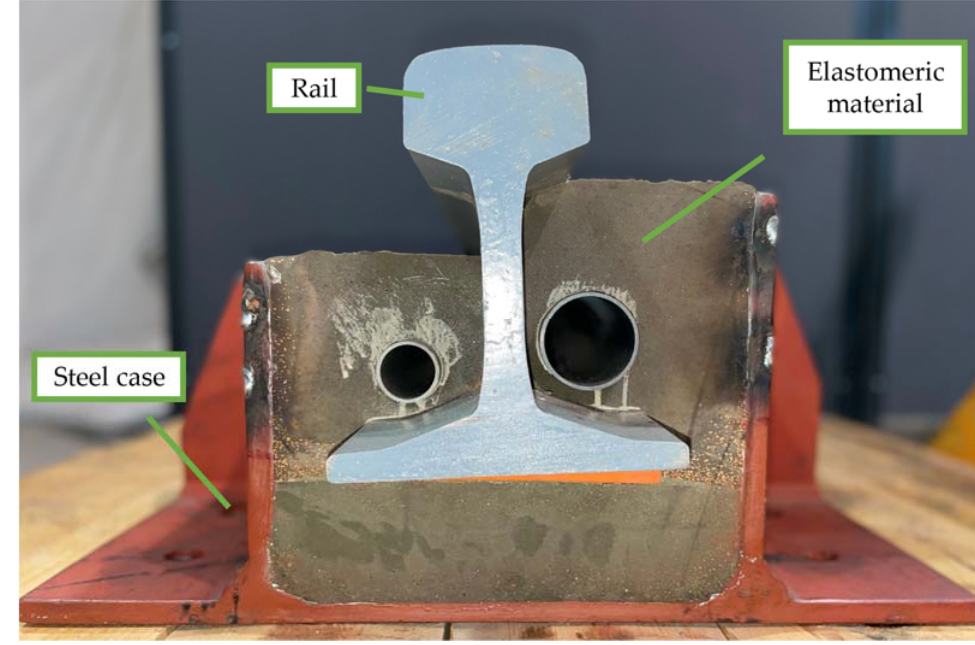
Figure 1. Section view of the reference Embedded Rail System (ERS).